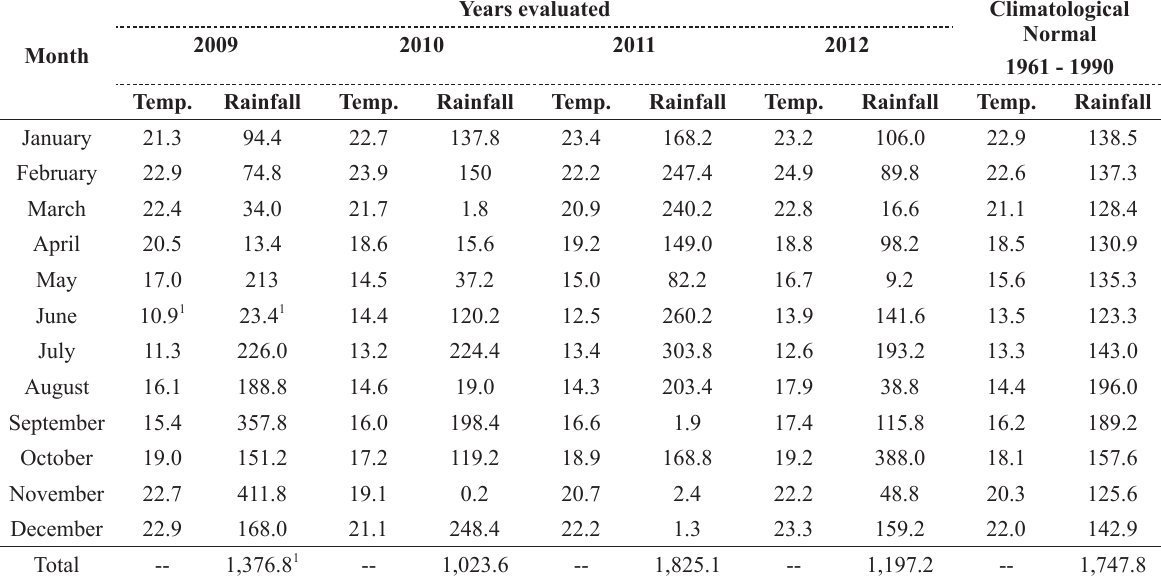
Average temperatures and rainfall in the years 2009, 2010, 2011, and 2012 for Palmeira das Missões, Rio Grande do Sul, Brazil. Years evaluated Climatological